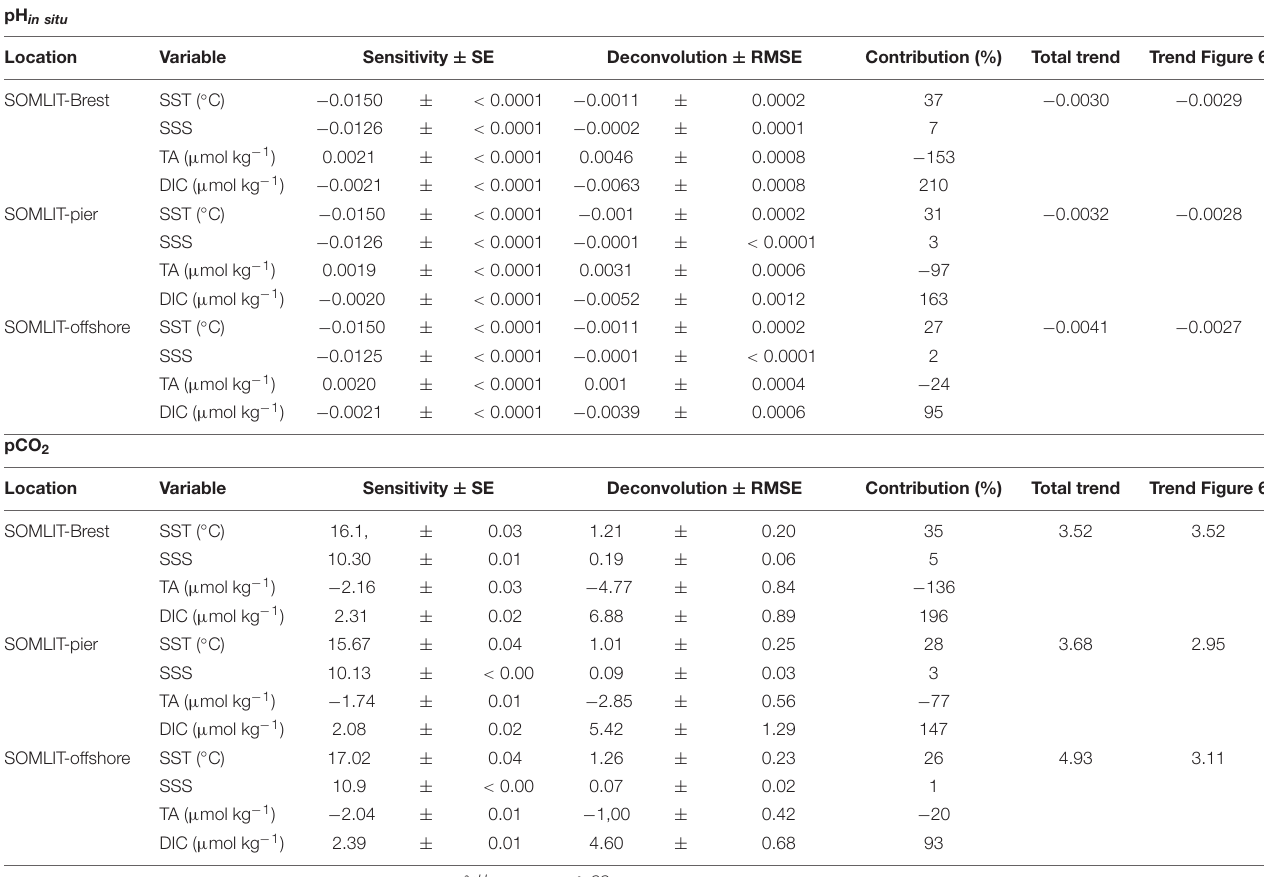
TABLE 2 | Deconvolution of pH in situ anomalies ( dpH in situ dt , year − 1 ) and pCO 2 anomalies ( dpCO 2 dt , µ atm year − 1 ) at SOMLIT-Brest, SOMLIT-pier, and SOMLIT-offshore. pH in situ